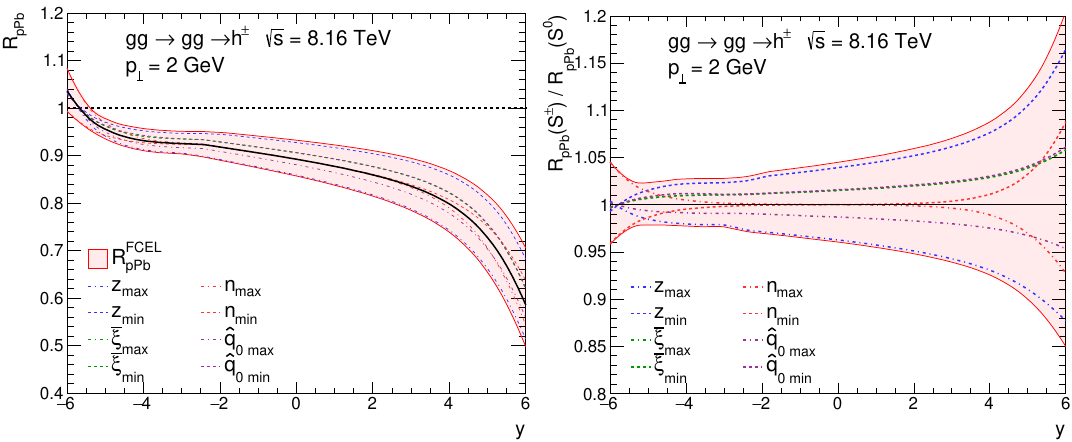
Figure 4 . Left: individual contributions R pA ( S (cid:6) the gg gg channel. Calculations are shown for maximal (dash-dotted lines) and minimal (dashed ! lines) values of z (blue), (cid:22) (cid:24) (green), n (red), and ^ q total uncertainty de(cid:12)ned by (4.1). Right: relative uncertainty R pA ( S (cid:6)